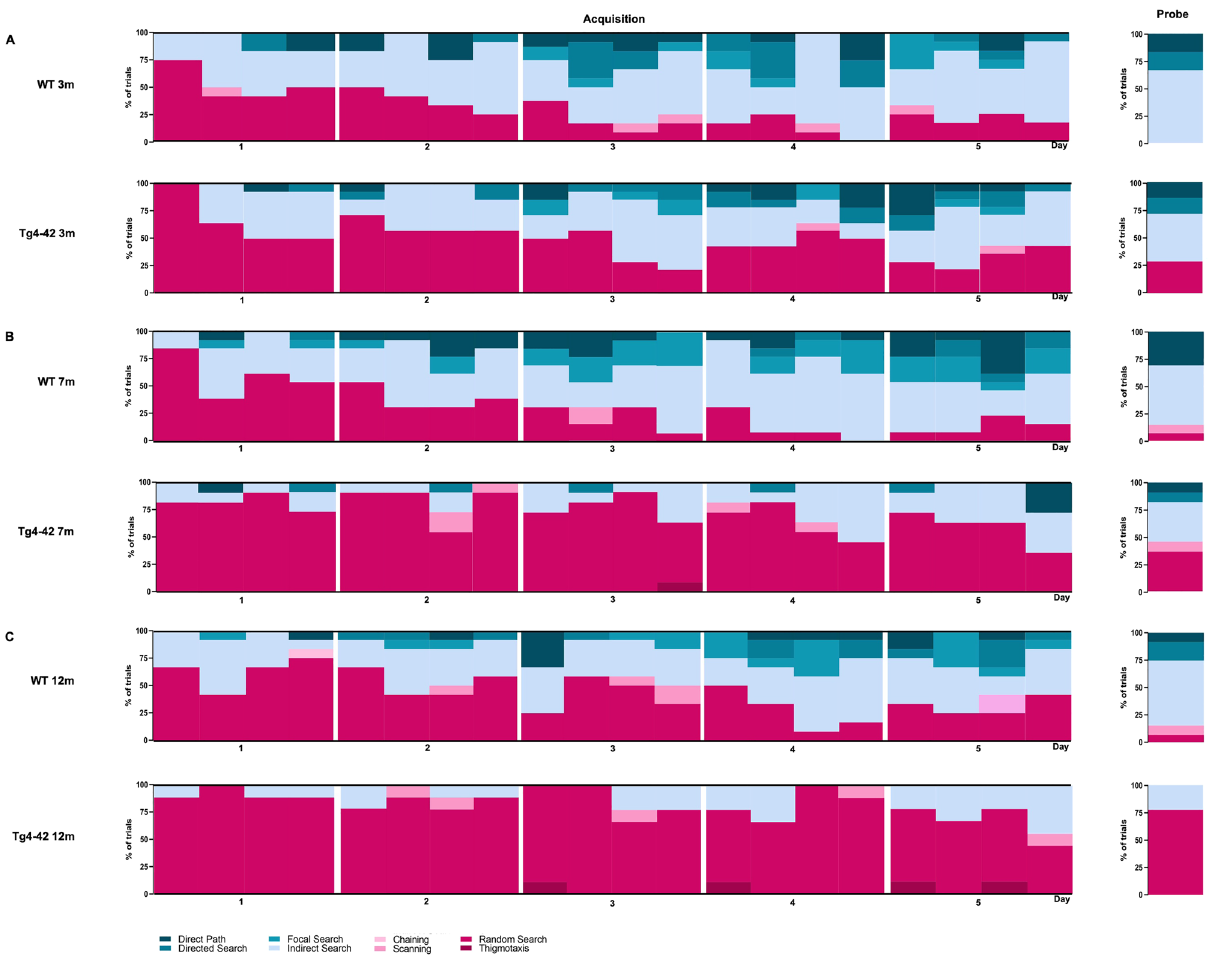
Figure 4. Qualitative analysis of spatial learning in Tg4-42 mice. Distribution of search strategies used by 3m ( A ), 7m ( B ) and 12m ( C ) old Tg4-42 and same-aged WT mice. WT animals showed a clear progression towards increasing spatial strategies over the 5 days of acquisition training. While non-spatial search strategies decreased in 3m Tg4-42 mice over the training days, Tg4-42 animals switched to spatial strategies significantly slower than WT animals. In contrast, 7m and 12m old Tg4-42 mice did not significantly change their search strategy pattern over the training days and mainly used non-spatial strategies. Data represents the percentage of search strategies performed in each trial over the 5 days of acquisition training and during the probe trial. n = relied significantly more on non-spatial strategies than WT animals (Fig. 6: two-way repeated measures ANOVA followed by Bonferroni multiple comparisons, genotype: 12m : p < 0.001). Consistent with these results, the cog- nitive score was significantly different between female 12 month-old Tg4-42 and WT mice in the acquisition training (Fig. 5E, two-way repeated measures ANOVA, genotype : 12m : F(1,19) = 45.34, p < 0.001). The cognitive score did not differ between 3, 7 and 12 month-old WT mice (two-way repeated measures ANOVA, WT age : F(2,34) = 4.478, p = 0.4602). In contrast, Tg4-42 showed a decreased cognitive score with age (two-way repeated measures ANOVA, Tg4-42 age : F(2,31) = 17.71, p < 0.001). During the probe trial 78% of 12-month-old Tg4-42 mice used a ‘random search’ strategy. In contrast, 83% F(8,11) = 3.877, p = 0.0010).